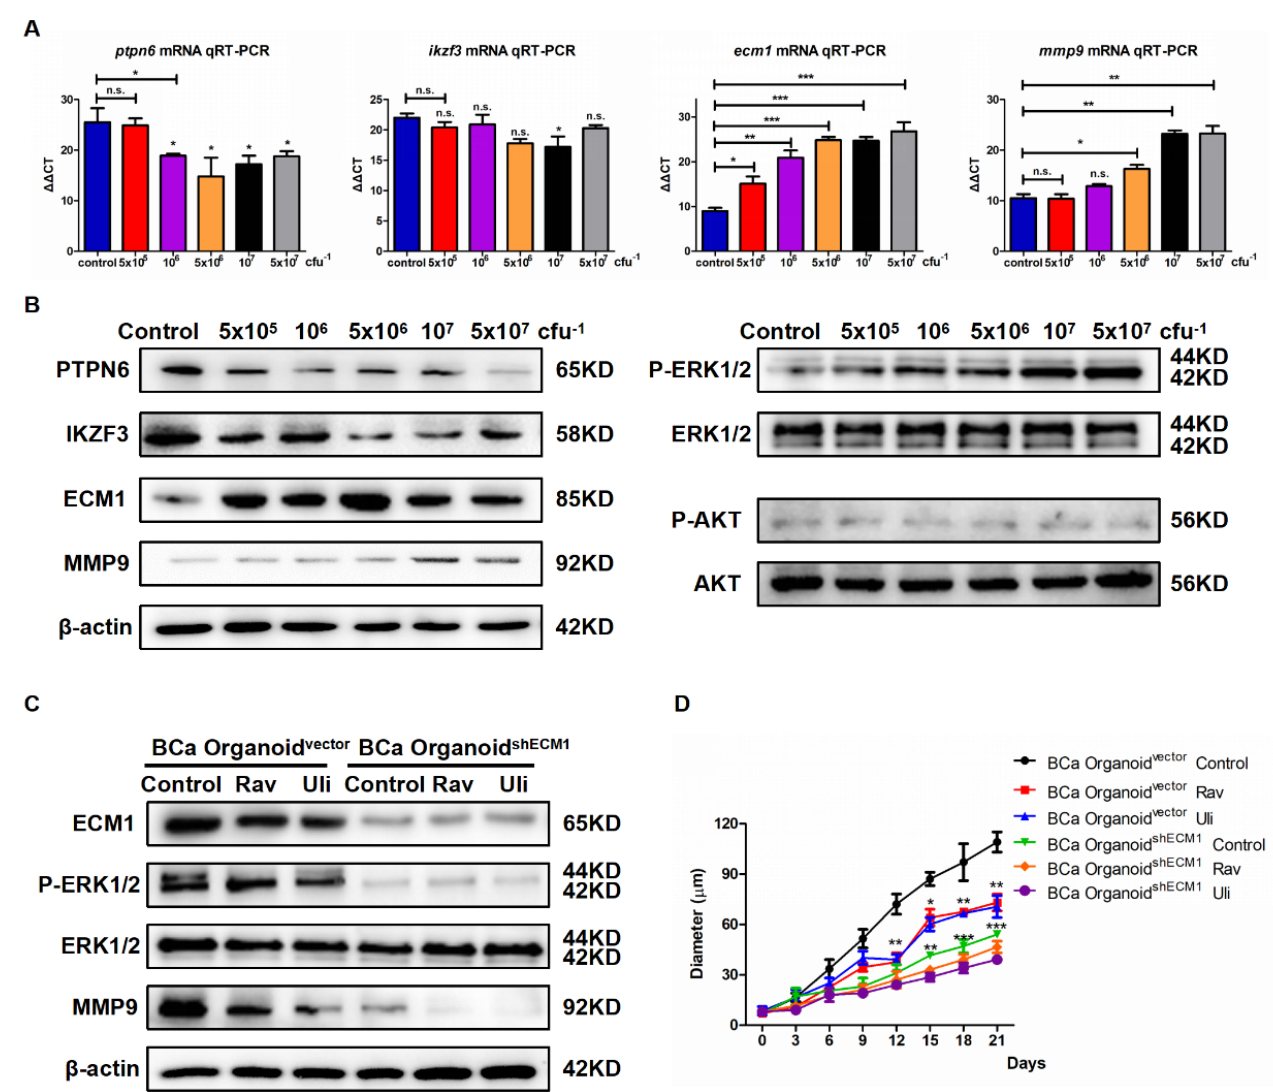
Figure 3. Eubacterium sp. CAG:581 activated the ECM1/ERK1/2 phosphorylation/MMP9 of NMIBC organoids. ( A ) qRT-PCR analysis of ptpn6, ikzf3, ecm1 , and mmp9 levels of NMIBC organoids cocul- tured with increased an gradient (5 × 10 5 , 10 6 , 5 × 10 6 , 10 7 , 5 × 10 7 cfu) of Eubacterium sp. CAG:581 . ( B ) Western blot analysis of PTPN6, IKZF3, ECM1, MMP9, ERK1/2 phosphorylation, and AKT phosphorylation in NMIBC organoids cocultured with an increased gradient (5 × 10 5 , 10 6 , 5 × 10 6 , 10 7 , 5 × 10 7 cfu) of Eubacterium sp. CAG:581 . ( C ) Western blot analysis of ECM1, MMP9, and ERK1/2 phos- phorylation in BCa organoid shECM1 and BCa organoid vector treated with 10 μM ravoxertinib (Rav) or ulixertinib (Uli). ( D ) Growth curve of BCa organoid shECM1 and BCa organoid vector treated with 10 μM ravoxertinib (Rav) or ulixertinib (Uli). Results are presented as mean ± SD, n = 3. * p < 0.05, ** p < 0.01, *** p < 0.001.